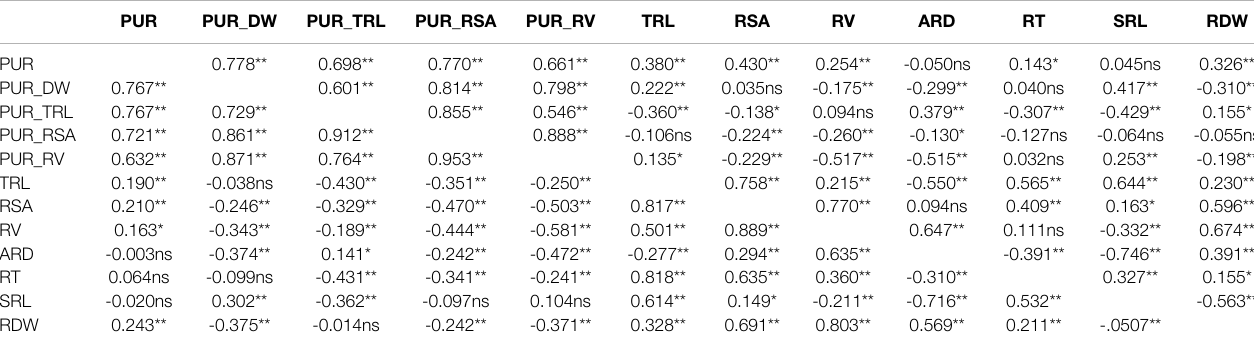
TABLE 3 | Relationships between PUR and root morphology/P absorption ef fi ciency traits under low-P (LP) and suf fi cient-P (SP) conditions.